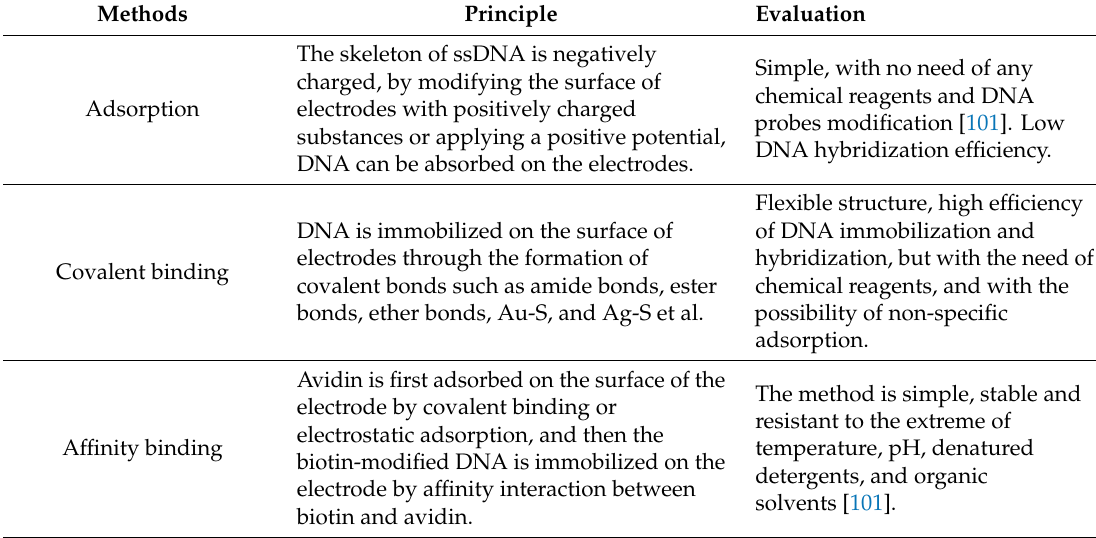
Table 3. Common methods of DNA